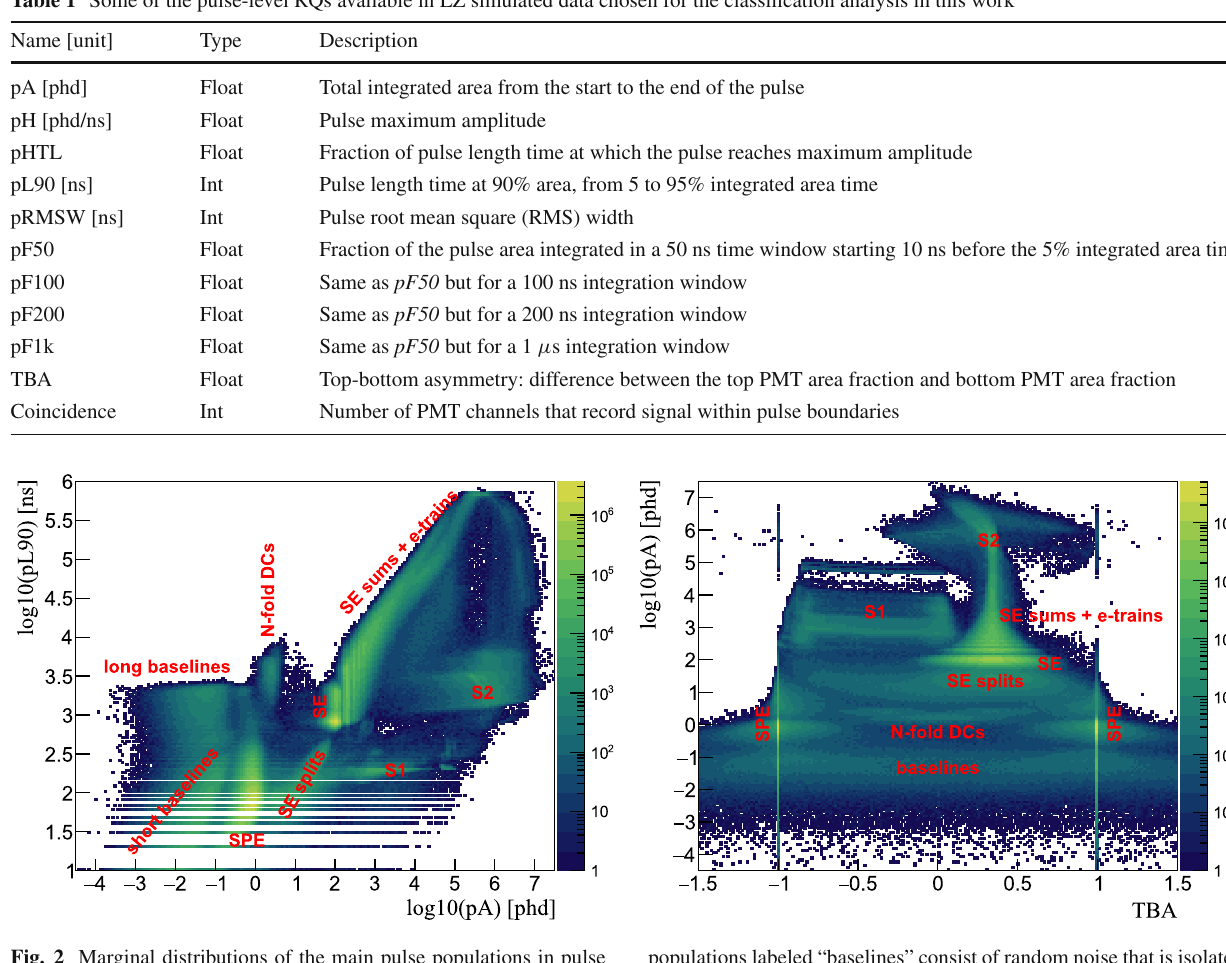
populations labeled “baselines” consist of random noise that is isolated by the pulse finding algorithm. The population labeled “N-fold DC” contains spurious pulses caused by random coincidences of PMT dark counts (DCs) in N PMT